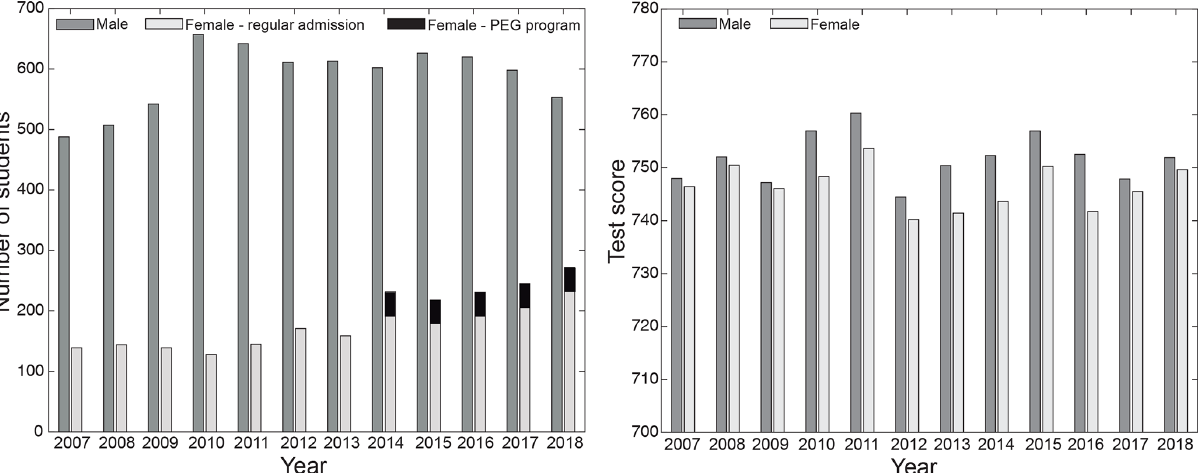
Figure 1. Number of students admitted to FCFM at Universidad de Chile and average enrollment score by gender for the period